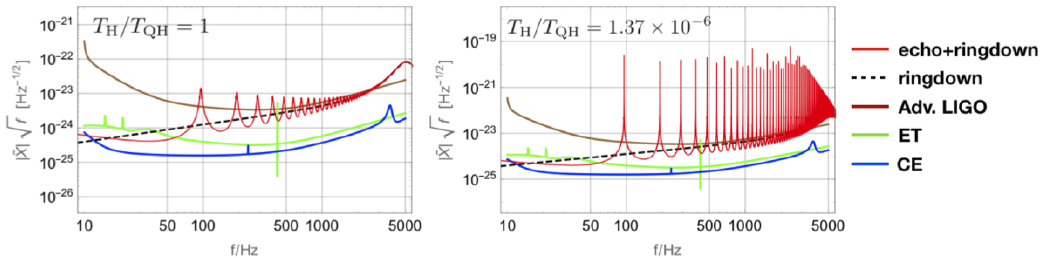
Figure 40. Spectra of ringdown and echo phases in the Boltzmann reflectivity model with ¯ a = 0.1, (cid:101) rd = 2.4 10 − 6 , M = 2.4 M , θ = 90 ◦ , and D o = 1 Mpc. Here we also assume γ = 10 − 10 , T H / T QH = 1 × (cid:12) (left) and T H / T QH = 1.37 10 − 6 ×